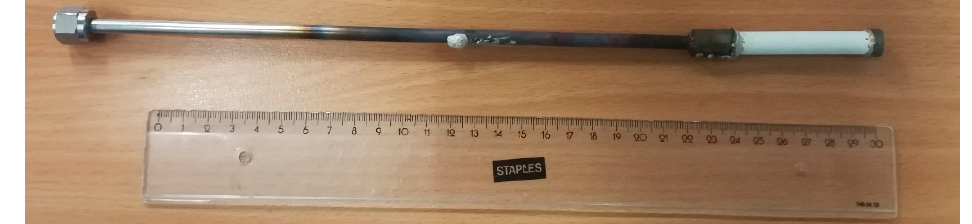
Figure 1. Picture of the sealed (by means of the reactive air brazing (RAB) sealing technique) MgO porous membrane used to carry out the membrane reactor experiments.